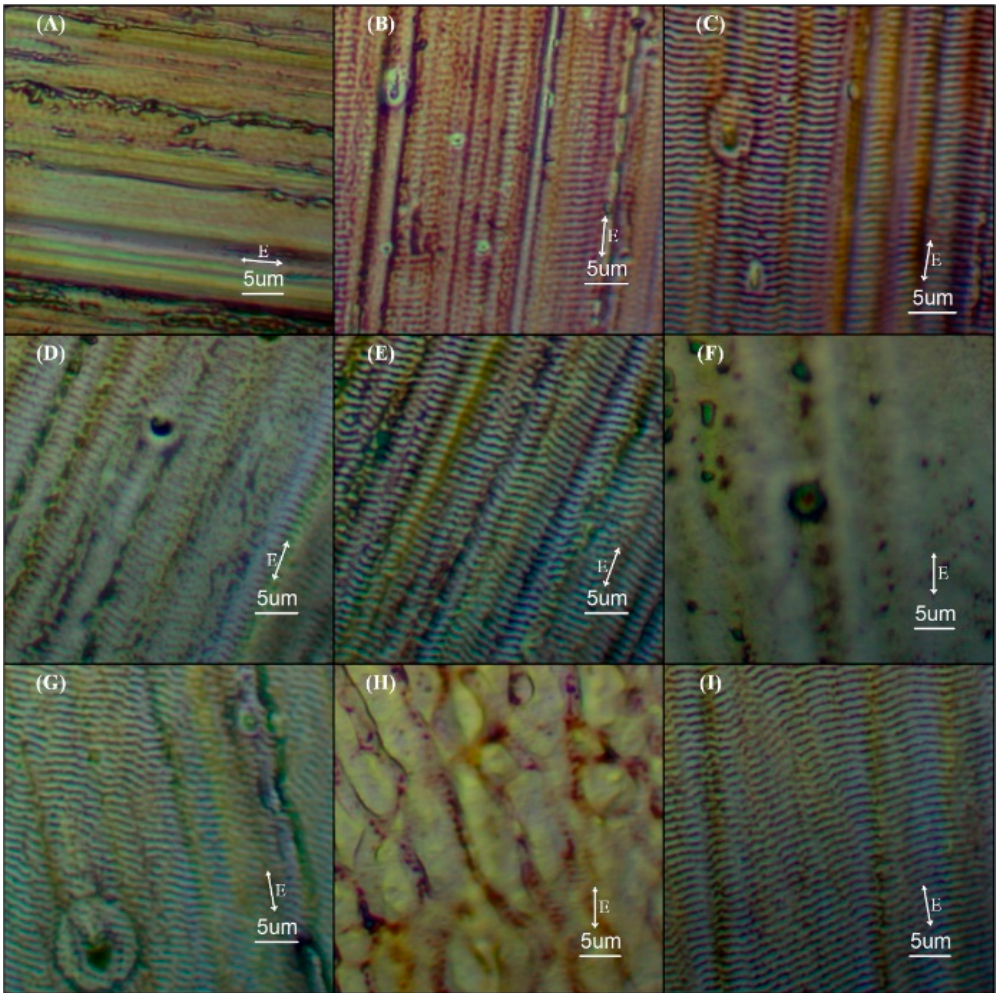
Figure6. Surfacemorphologyofsamples( N = 75). ( A ) ϕ = 0.522J / cm 2 , thespotcentre; ( B ) ϕ = 0.726J / cm 2 , Figure 6. Surface morphology of samples ( N = 75). ( A ) φ = 0.522 J/cm 2 , the spot centre; ( B ) φ = 0.726 thespotcentre; ( C ) ϕ = 0.955J / cm 2 , thespotcentre; ( D ) ϕ = 1.592J / cm 2 , thespotcentre; ( E ) ϕ = 1.592J / cm 2 , J/cm 2 , the spot centre; ( C ) φ = 0.955 J/cm 2 , the spot centre; ( D ) φ = 1.592 J/cm 2 , the spot centre; ( E ) φ = facula edge; ( F ) ϕ = 2.268 J / cm 2 , the spot centre; ( G ) ϕ = 2.268 J / cm 2 , facula edge; ( H ) ϕ = 2.952 J / cm 2 , 1.592 J/cm 2 , facula edge; ( F ) φ = 2.268 J/cm 2 , the spot centre; ( G ) φ = 2.268 J/cm 2 , facula edge; ( H ) φ = the spot centre; ( I ) ϕ = 2.952 J / cm 2 , facula 2.952 J/cm 2 , the spot centre; ( I ) φ = 2.952 J/cm 2 , facula edge.